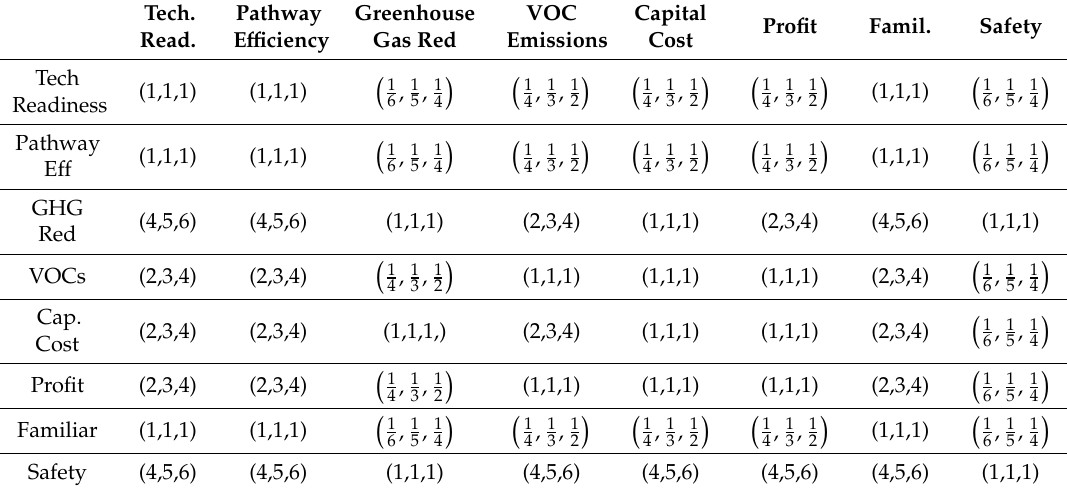
Table 17. Fuzzy AHP Comparisons for Focus on GHG Reductions and Safety (Source: own results). Tech.